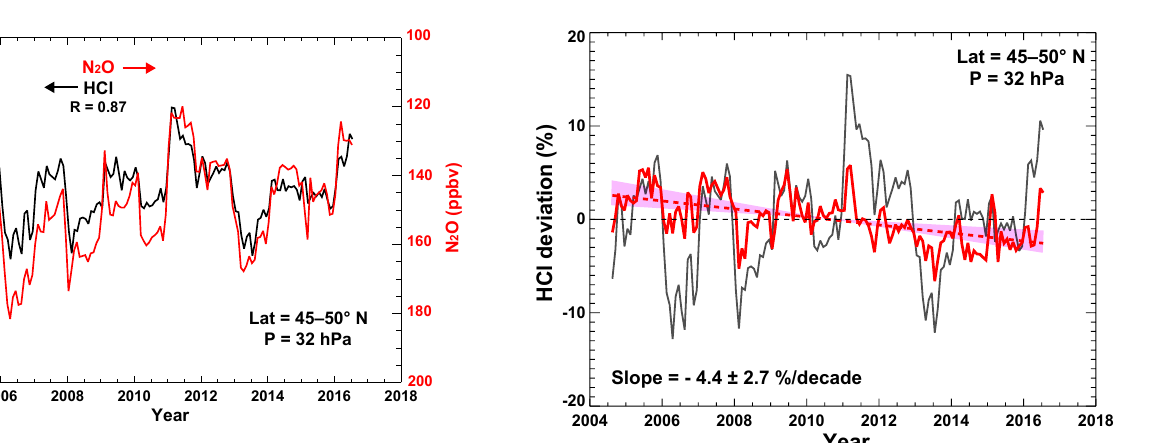
Figure 4. HCl anomaly time series as in Figs. 2 and 3 with the mean removed (black) and the residual time series after regression to N 2 O time series (red). Red dashed line is linear fit to residual series with 2 σ uncertainty bounds indicated by shaded